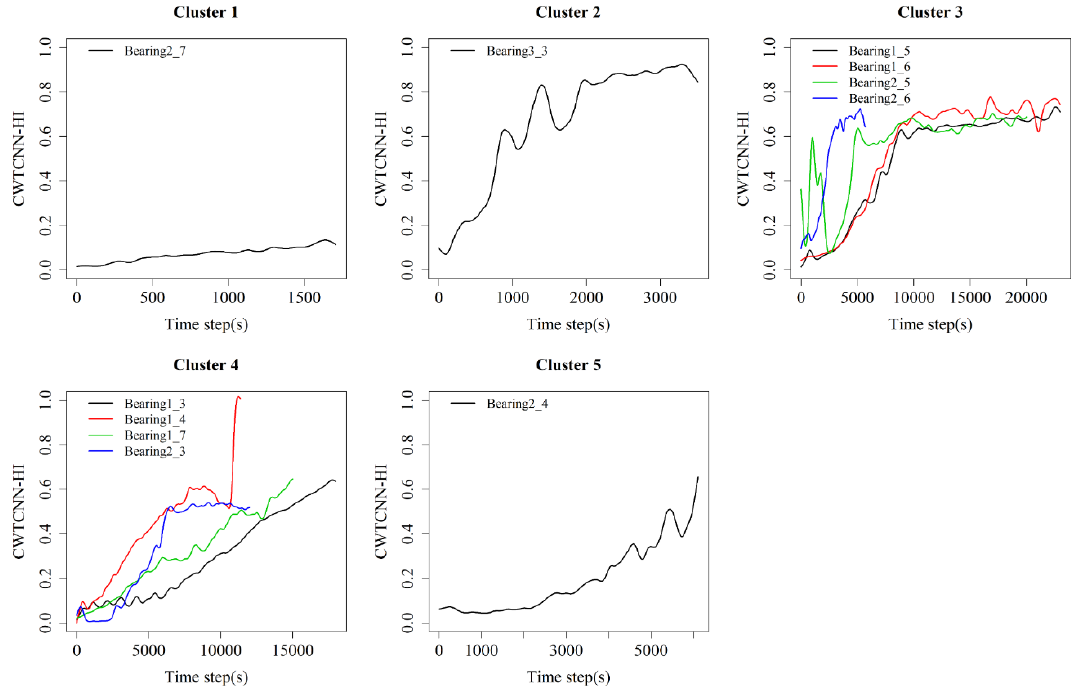
Figure 12. Clustering results of the testing datasets.